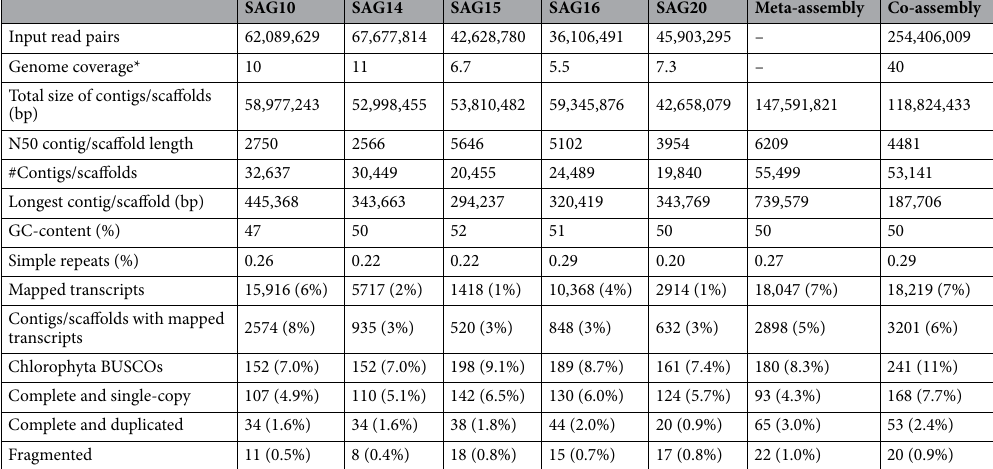
Table 3. Comparison of the genome assemblies using three different assembly strategies. SAG10-20 refers to the separate assemblies of the different SAG read libraries. Meta-assembly is the assembly of the five SAG assemblies. Co-assembly is the assembly of the five SAG libraries pooled. Scaffolds or contigs shorter than 500 bp are removed from all assemblies and the calculation of the N50s. Contigs/scaffolds refers to either contigs in the and SAG- and Co-assemblies, or scaffolds in the meta-assembly. *Genome coverage was calculated by the total nr of input bases to each assembly divided by the estimated size of the diploid A. acetabulum genome (1764Mb).